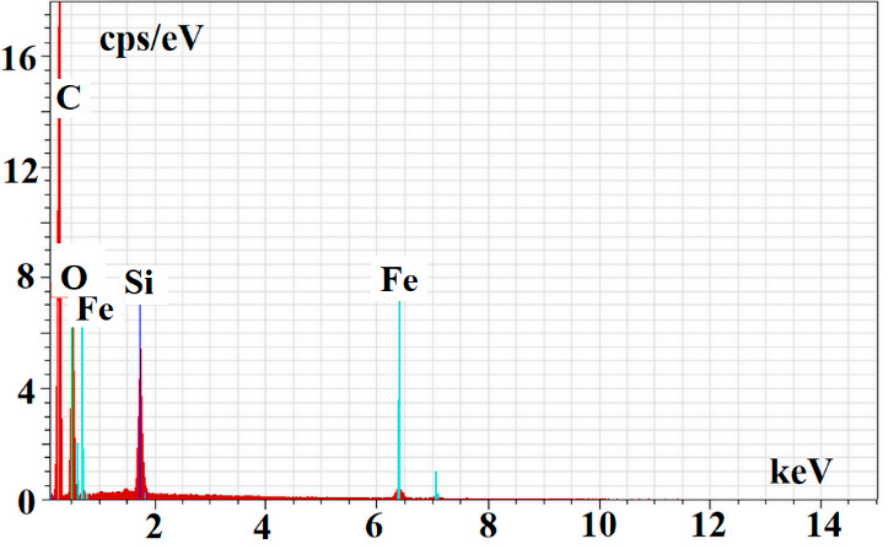
Figure 5. EDS spectrum of m-MIP.